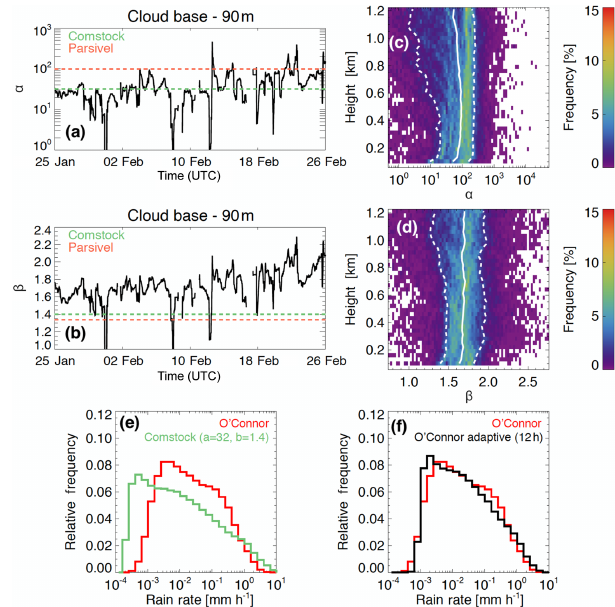
Figure 6. Time series of the α (a) and β (b) coefficients used to es- timate precipitation rate 90m below cloud base height for a 30d pe- riod that overlaps with the second phase of the ACE-ENA field cam- paign. For the same time period, distribution of the α (c) and β (d) coefficients with height, along with their median (solid line) and 25th and 75th percentile values (dashed line). Precipitation rate dis- tributions retrieved using the O’Connor et al. (2005) technique (red) and estimated using the adaptive coefficients ( f , black) or the fixed coefficients proposed by Comstock et al. (2004) ( e , green). Com- stock et al. (2004) coefficients and coefficients determined from dis- drometer observations are both presented in panels (a) and (b) using dashed green lines and dashed orange lines, respectively.